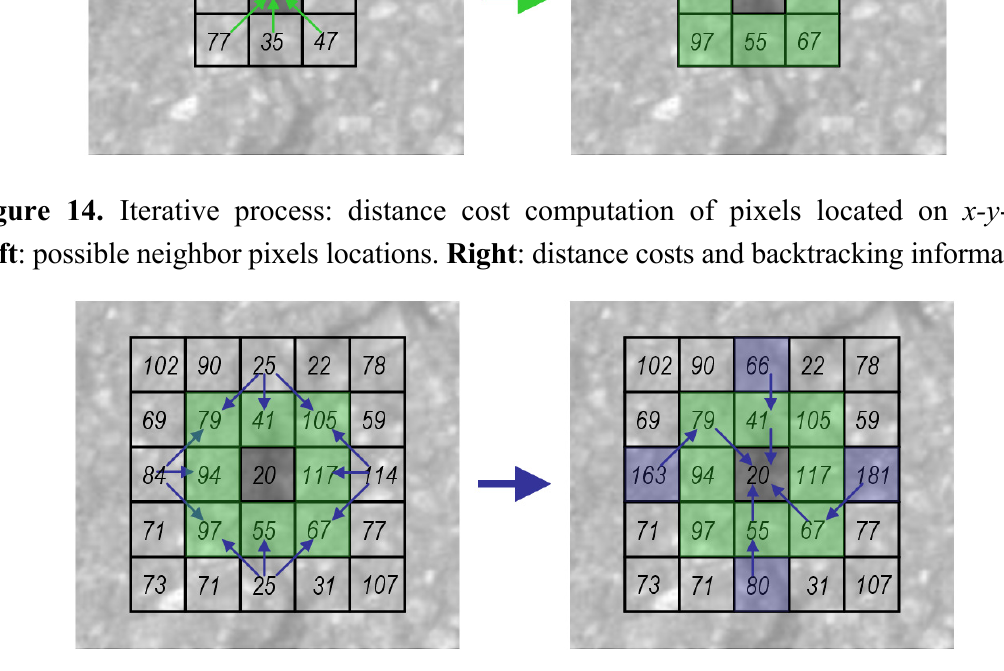
Figure 15. Iterative process: distance cost computation of pixels located on quadrants. Left : possible neighbor pixels locations. Right : distance costs and backtracking